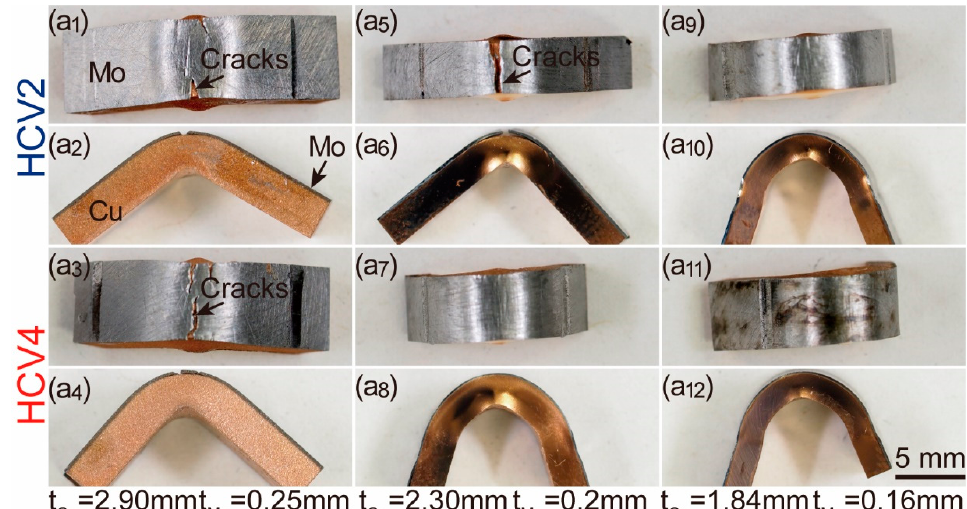
Figure 8. Top-view and cross-sectional OM images of the HCV2 and HCV4 clads after bending tests. (a1)–(a6) Some of the Mo plates in the specimens failed during bending tests, (a7)–(a12) while no failure was observed in the specimens with large bending strain of about 40%.